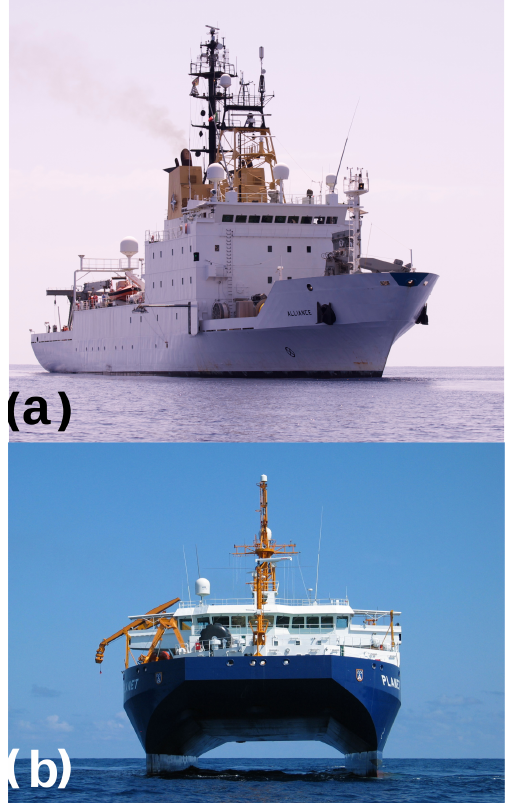
Figure 1. (a) NATO research vessel (NRV) Alliance and (b) RV Planet .